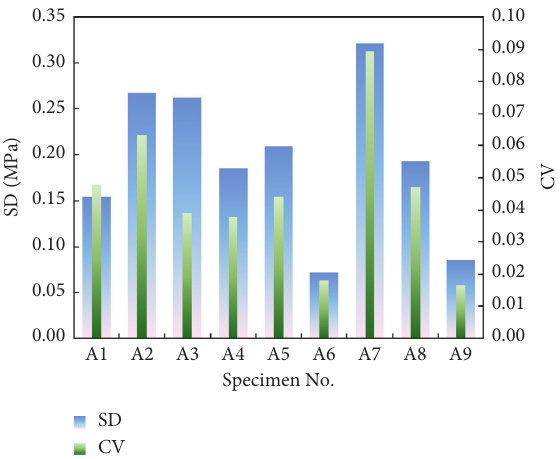
Figure 13: Variability of peak stresses.